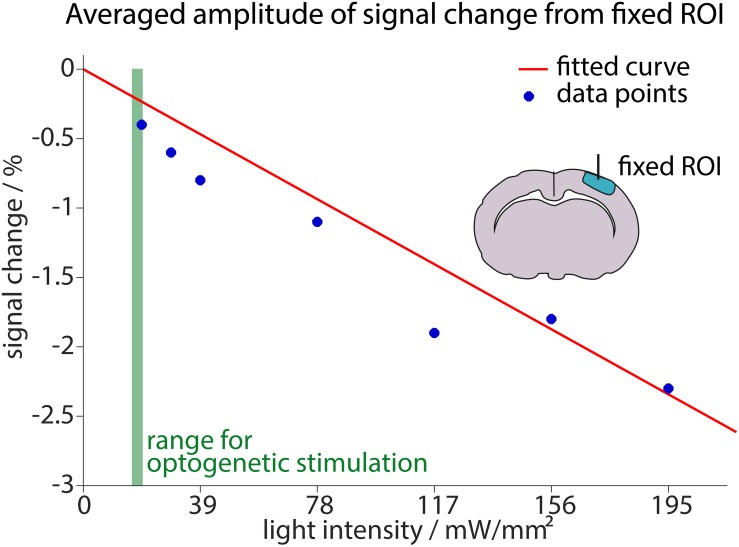
Estimation of signal reduction due to light application. The averaged maximum amplitudes of signal changes in a small ROI around the fiber are plotted against the applied light intensity (blue dots). The linear fit including these measurements and the origin (0, 0) is shown in red. Fit result was f(x) = –0.013x (95%-confidence intervals between –0.01509 and –0.01068 for the fit). Measurements were performed for light intensities ranging from 19.5 mW/mm2 to 195 mW/mm2. For reference, the range of light intensities used for optogenetic stimulation in this study (14.6–19.5 mW/mm2) is shown in green.